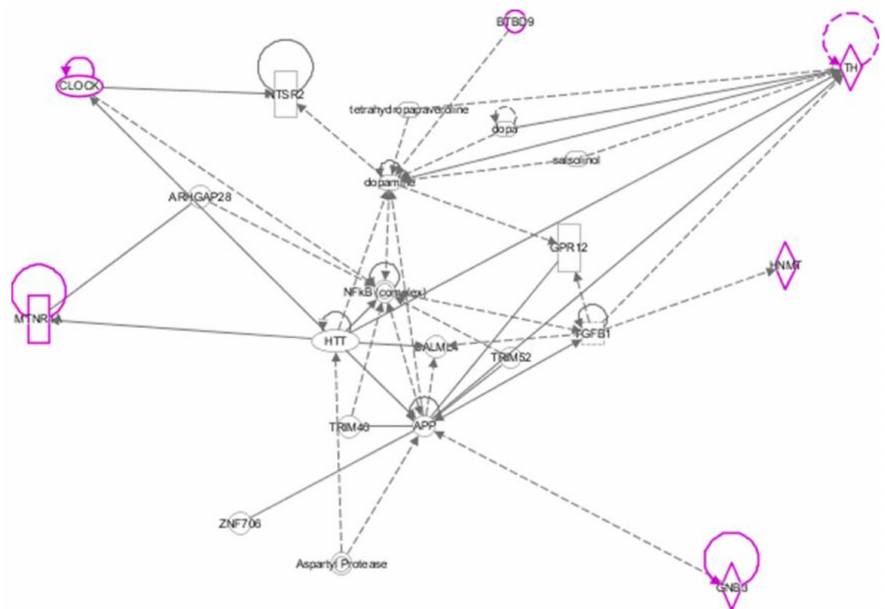
Figure 2. IPA pathway analysis, in which specific genes emerged throughout our review, are shown in purple. As can be seen, GNB3 enhances APP (Amyloid precursor protein) expression, which has been suggested to have growth promoting properties and a role in neuron plasticity. APP is linked with the expression of TGFB1, which encodes a protein that regulates various cell activities including proliferation, differentiation, motility of cells, and apoptosis. TGFB1 is possibly related to an increase in the expression of TH, which is the rate limiting enzyme in the synthesis of dopamine [28]. Tyrosine hydroxylase is a crucial enzyme for converting tyrosine to DOPA in the pathway of the catecholamine biosynthesis. Diurnal expression of TH is mirrored by the diurnal availability of dopamine in the central nervous system. The protein product of the CLOCK gene is a transcription factor with a crucial role in circadian rhythm regulation, which is suggested to be positively linked to the expression of another transcription factor, the protein of the NF-kB gene. The latter also exhibits a central role in circadian and immune